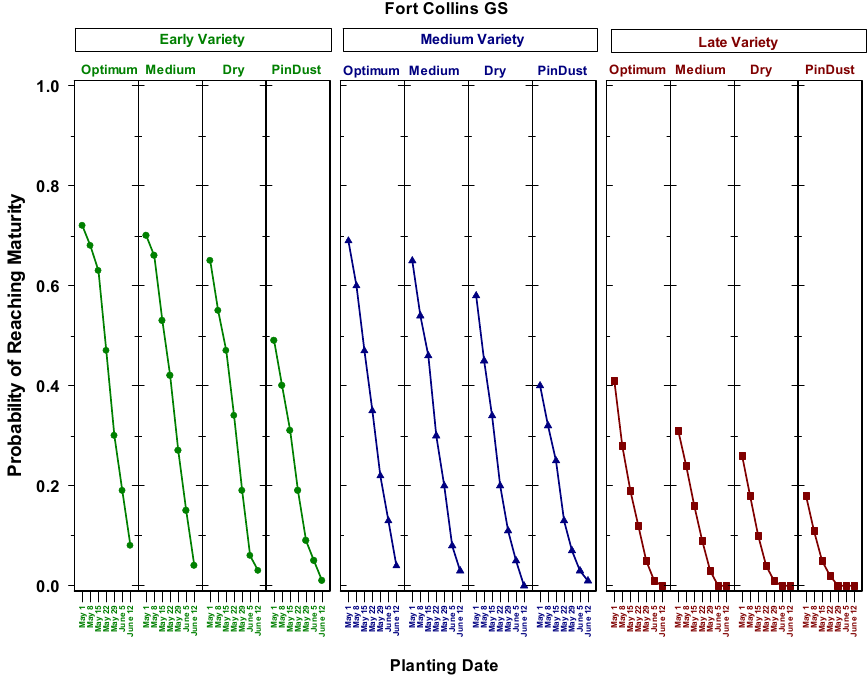
Figure 8. Probability of sorghum reaching physiological maturity at Fort Collins, Colorado, for seven planting dates using non ‐ stressed (GS) phenological parameters, three maturity classes, and four seedbed water conditions at planting.